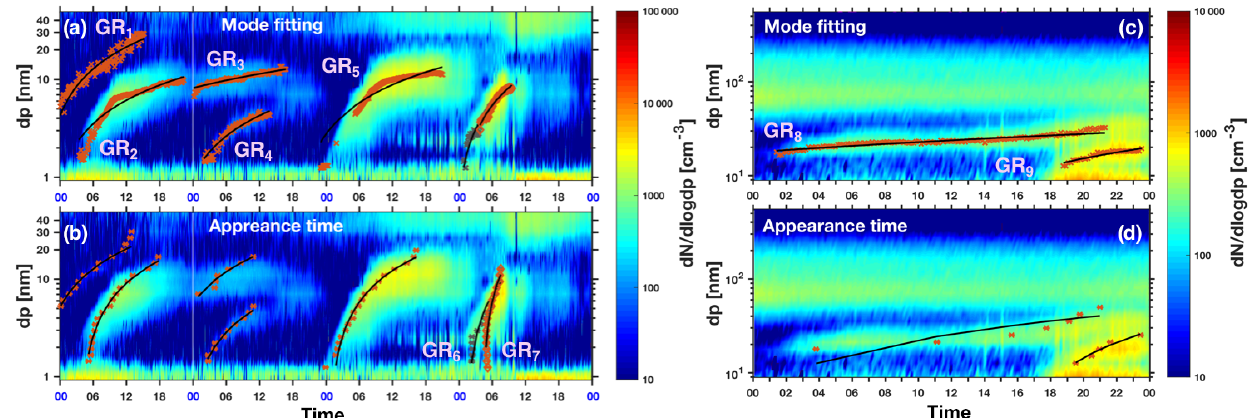
Figure 5. Comparison of GR for nine growth modes (GR i , i = 1 ,..., 9 in the figure) determined by the mode-fitting method (a, c) and by the appearance time method (b, d) , from the AIS measurement for 9–12 March 2011 (left-hand panels) and from the DMPS measurement for 25 February 2011 (right-hand panels). Growth rates estimated from linear fittings with root-mean-square errors expressed as uncertainties are shown in Table 1. The red or grey dots depict the estimated size evolution of ions/particles with respect to time determined by the mode-fitting or appearance time methods, with the linear fits to these size–time relationships shown as black